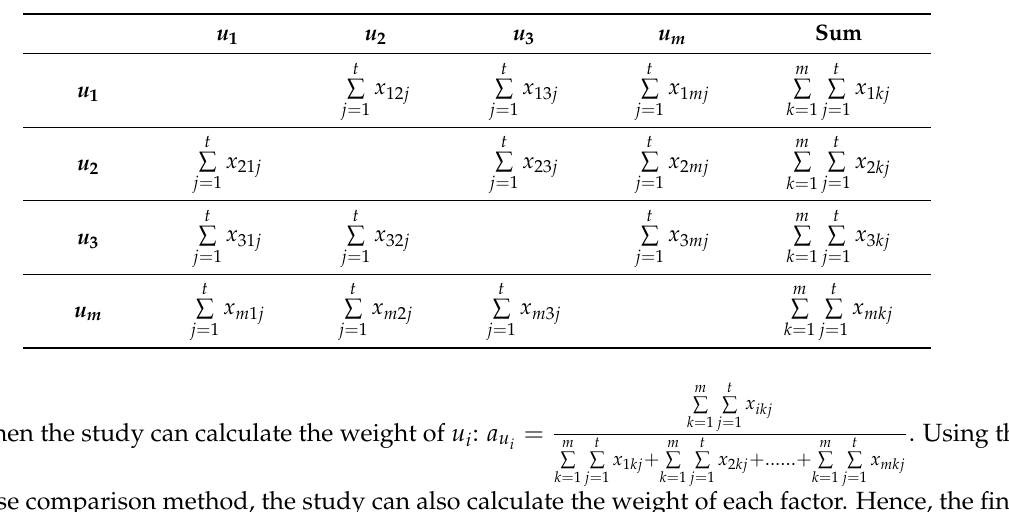
Table 7. The pairwise comparison matrix of all